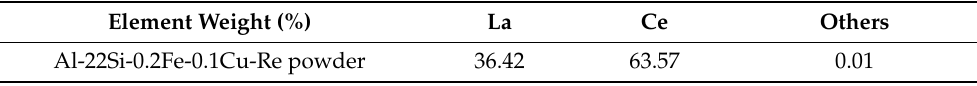
Table 3. Weight percent composition of Re (mixed rare earth